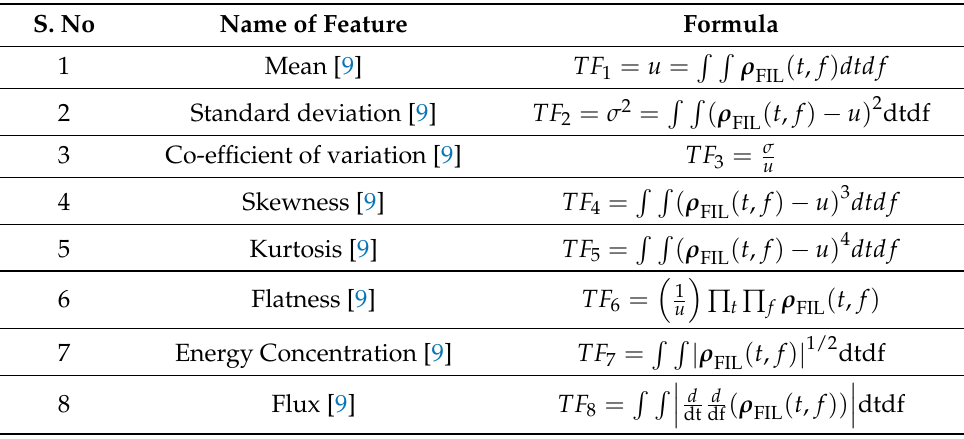
Table 2. List of features along with their respective